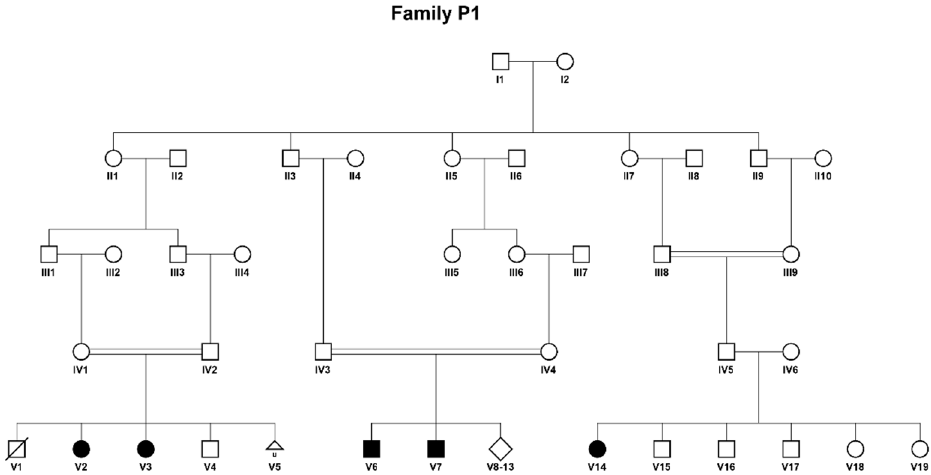
Figure 1. Pedigree of the consanguineous extended Bedouin family studied. Individuals affected with MADD are represented by full symbols. Patient V1 succumbed before molecular investigations were performed.